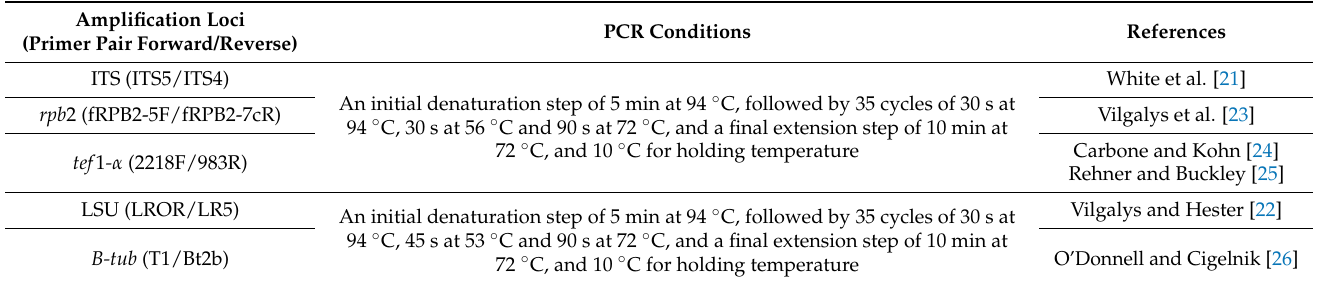
Table 1. The PCR primers and amplifying conditions used in this